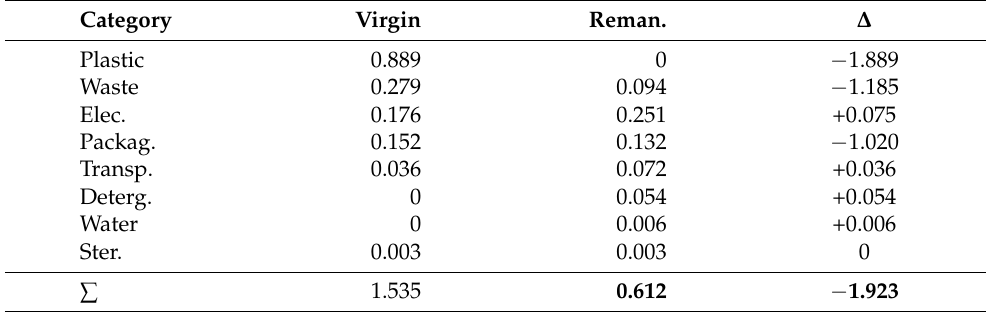
Table 6. Burden-free catheter remanufacturing emission savings. Our analysis shows that catheter remanufacturing reduces climate emissions by 60% . The results are given in kg CO 2